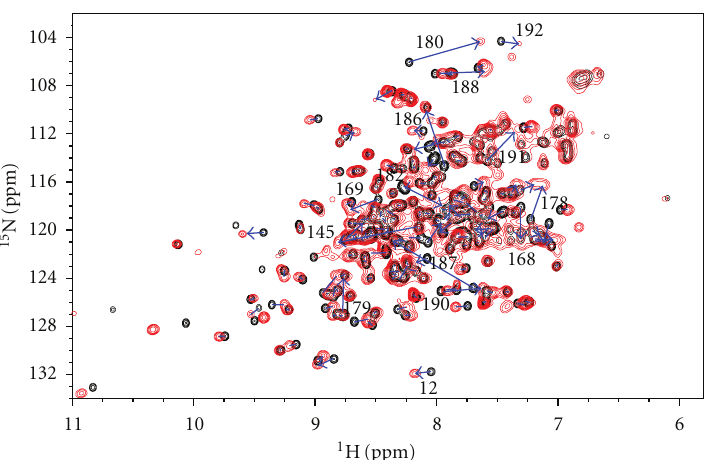
Figure 6: Overlay of 1 H- 15 N correlation spectra of [U- 15 N]-RPP30 free (black) and bound to unlabeled Pop5 (red). Arrows highlight chemical shift perturbations induced by the addition of Pop5. Select perturbed amides are labeled with the residue assignment. rich in basic residues, which could potentially play a critical role in RNA